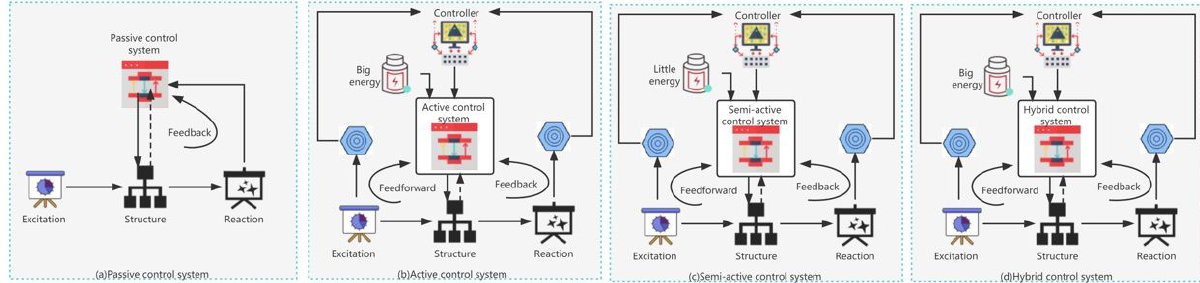
Figure 1: Examples of each control system